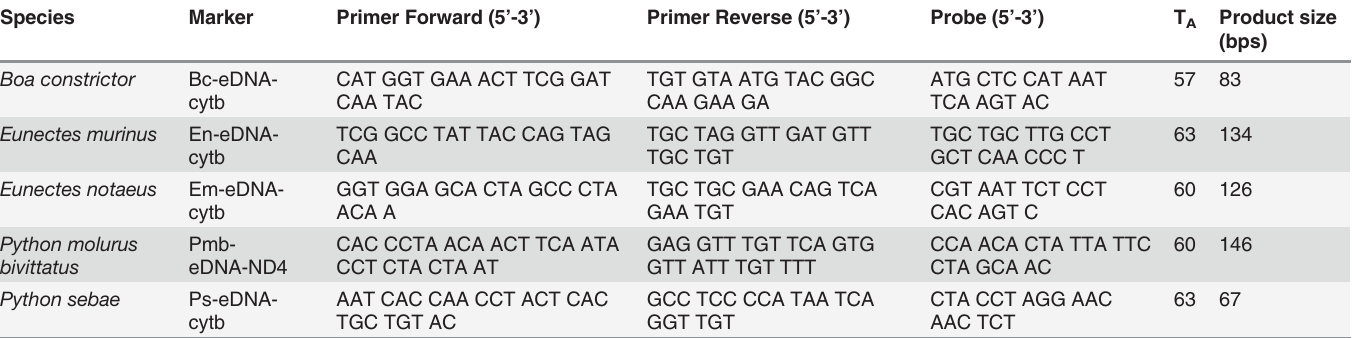
Table 1. Environmental DNA quantitative PCR (qPCR) primer and probe sequences, annealing temperature (T A ), and product size in base-pairs for five giant constrictor invasive species.